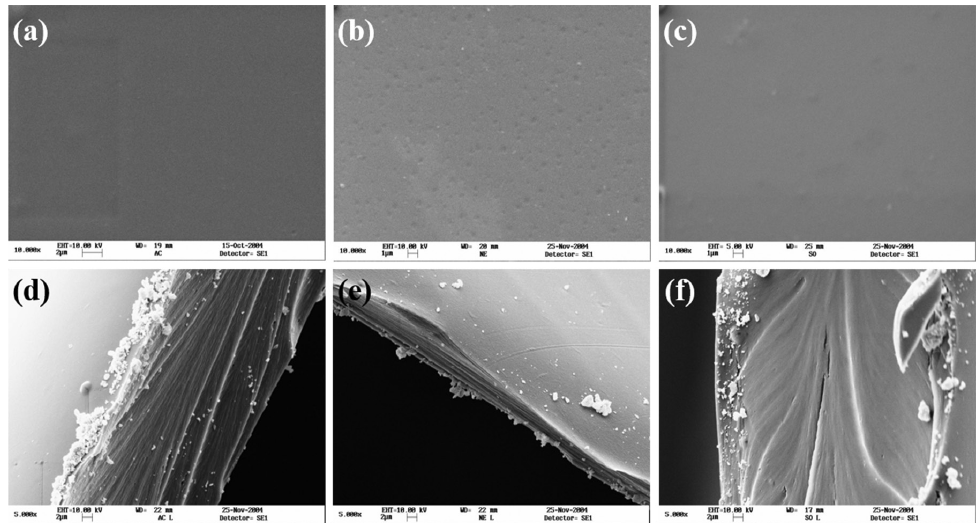
Figure 2. Micrographs of membranes. (a) Surface of chitosan membrane (CA); (b) Surface of chitosan neutralized membrane (CN); (c) Surface of sorbitol-chitosan plasticized membrane (CP); (d) Section of chitosan membrane (CA); (e) Section of chitosan neutralized membrane (CN); (f) Section of sorbitol-chitosan plasticized membrane (CP).